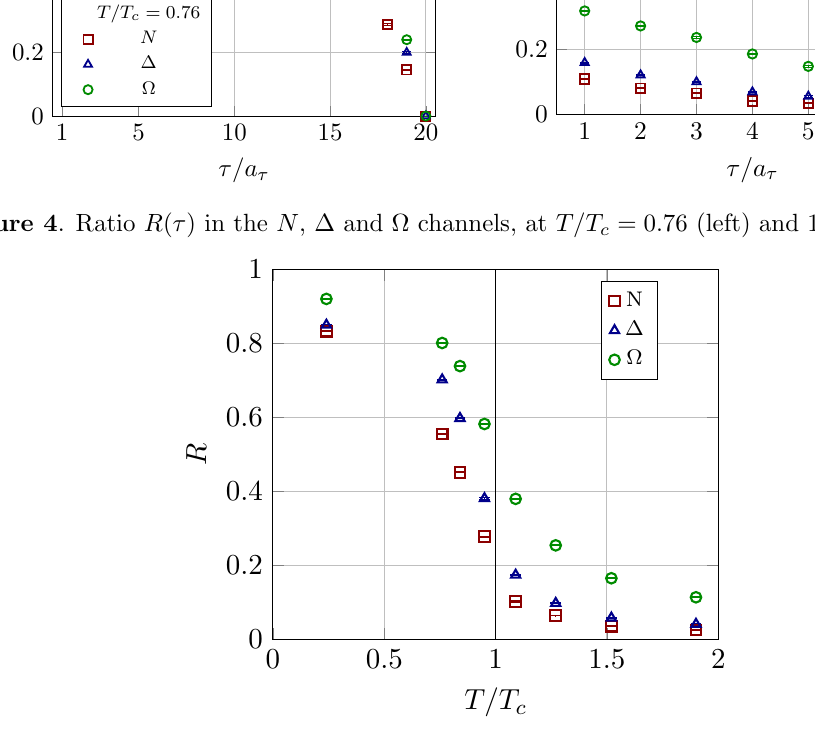
Figure 5 . Temperature dependence of R in the N , (cid:1) and (cid:10)